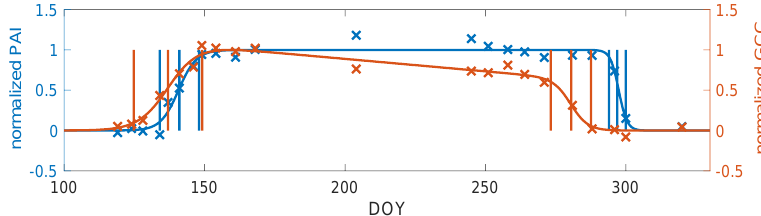
Figure 4. Smoothed (curve) and raw (× symbols) PAI and G CC curves for an example microsite, and the dates derived from each data source (vertical lines show the SOS, MOS, EOS, SOF, MOF, and EOF dates). Values are normalized to have minimum 0 and maximum 1 according to the curve fits, to facilitate the comparison of PAI and G CC trajectories.